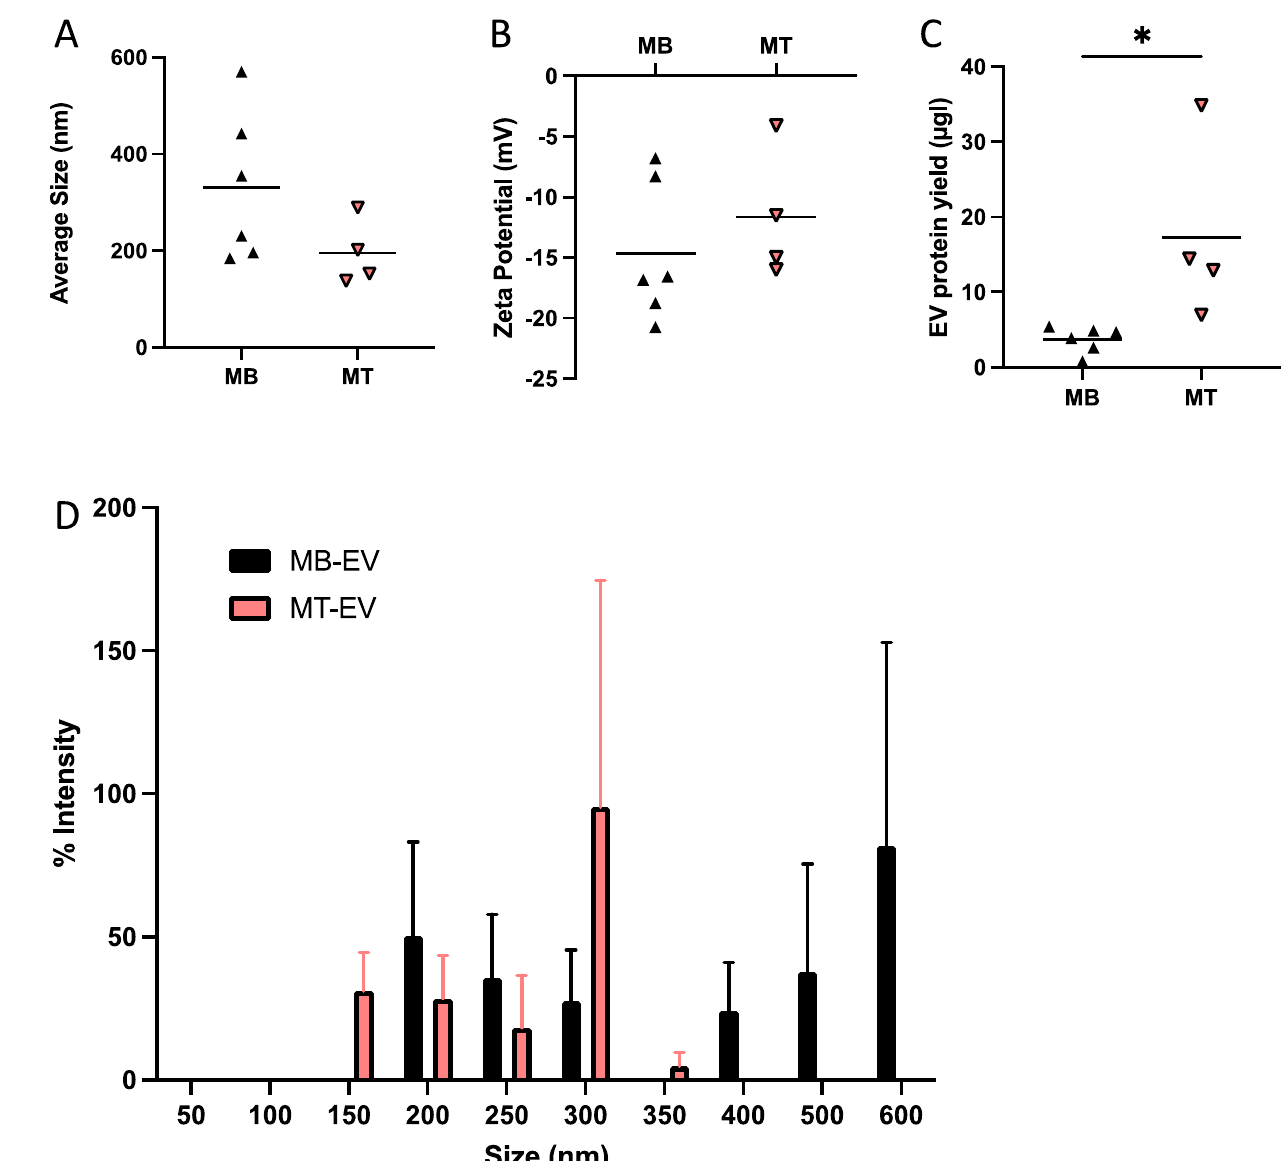
Figure 2. Differences between myoblast (MB) vs. myotube (MT) EV biophysical characteristics when isolated using differential ultracentrifugation (dUC). C2C12 myoblast- and myotube-EVs isolated via dUC showed no difference in ( A ) average EV size or ( B ) zeta potential ( n = 4–6). ( C ) Myotube EV protein yield was 4.79-fold higher than myoblast EV protein yield (* p < 0.05, n = 4–6). ( D ) Myoblast EVs display a bimodal size distribution profile with an increase at 200 nm and again at 600 nm, compared to myotubes EVs that were largely enriched with EVs 150–300 nm ( n = 4–6). All data were analyzed using an unpaired Student’s t test, except in Figure 2D where a 2-way ANOVA was used. Data are expressed as scatter plots showing mean, or as bar graphs with mean ± standard error.